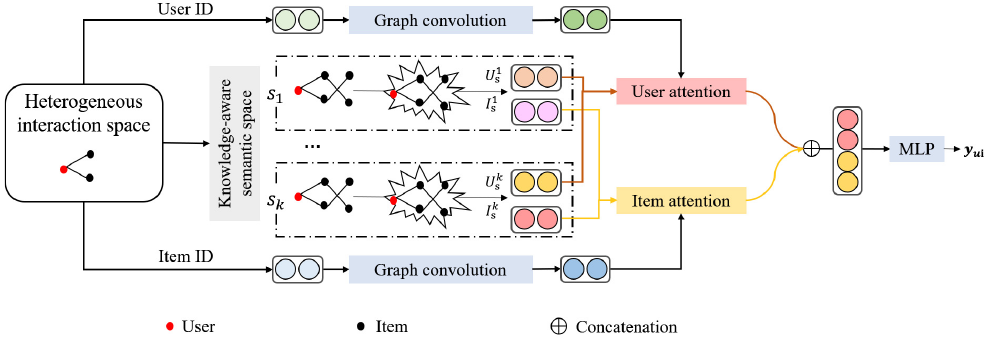
Figure 1. Framework of the proposed knowledge-aware multispace embedding learning (KMEL) for personalized